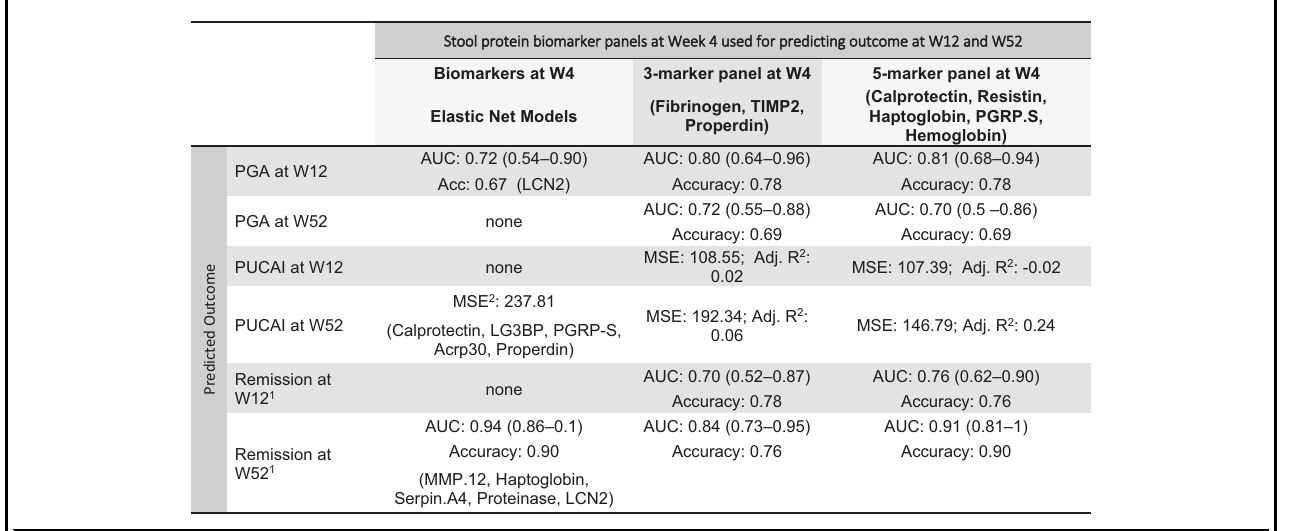
Table 2 Comparison of AUC, Accuracy, and MSE2 values of stool protein biomarkers at week 4 in predicting long-term outcome.